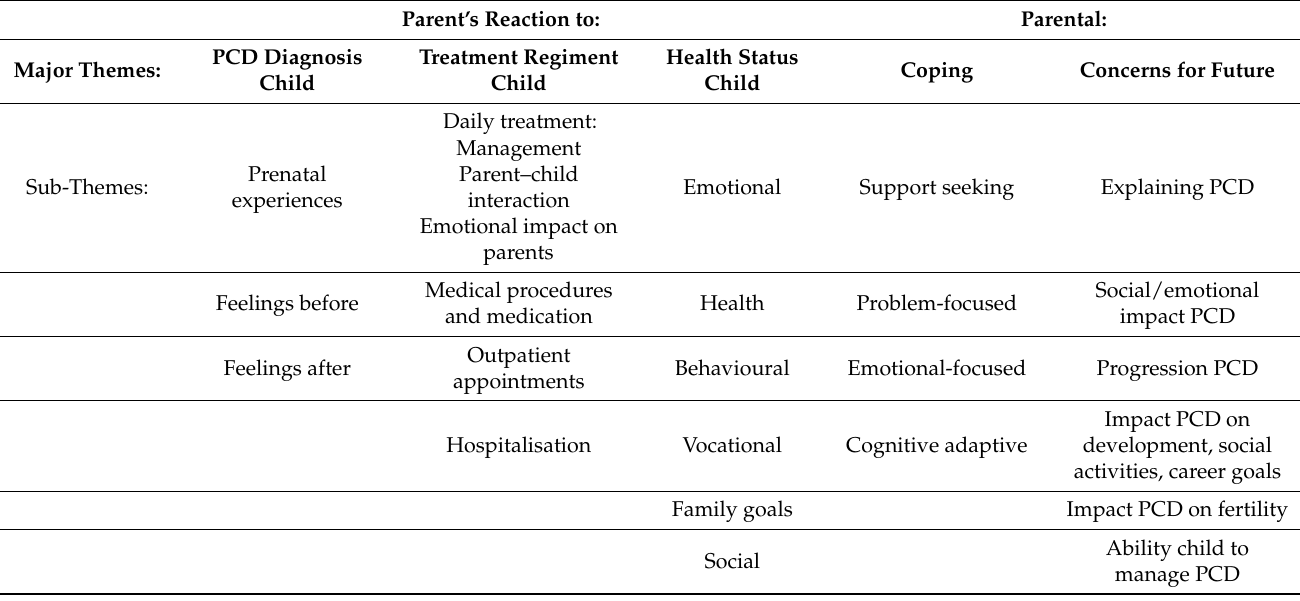
Table 2. Thematic